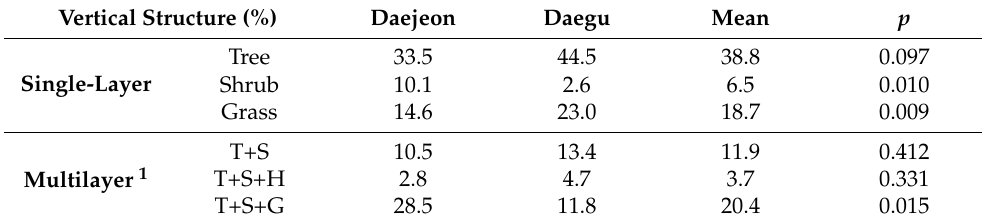
Figure 2. Distribution of study park tree DBHs. Table 5. Vertical planting structures in the study parks.